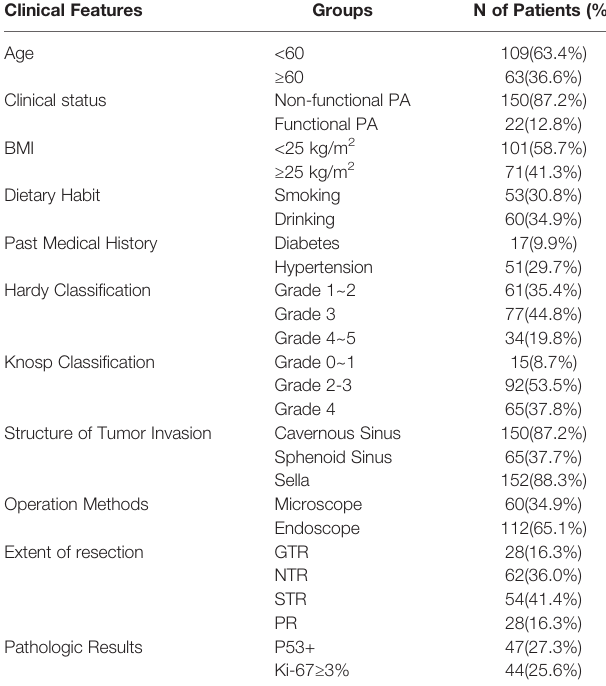
TABLE 1 | General